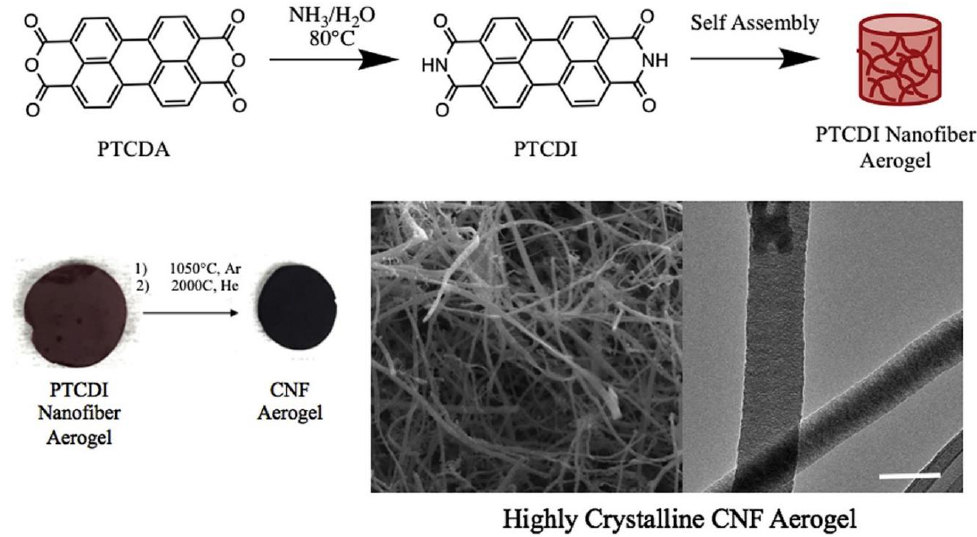
Figure 16. Schematic of perylene tetracarboxyldiimide (PTCDI) self-assembling in water and two-step pyrolysis for crystalline carbon nanofiber aerogel formation. Reprinted with permission from [57]. Copyright © 2019 Elsevier Ltd.